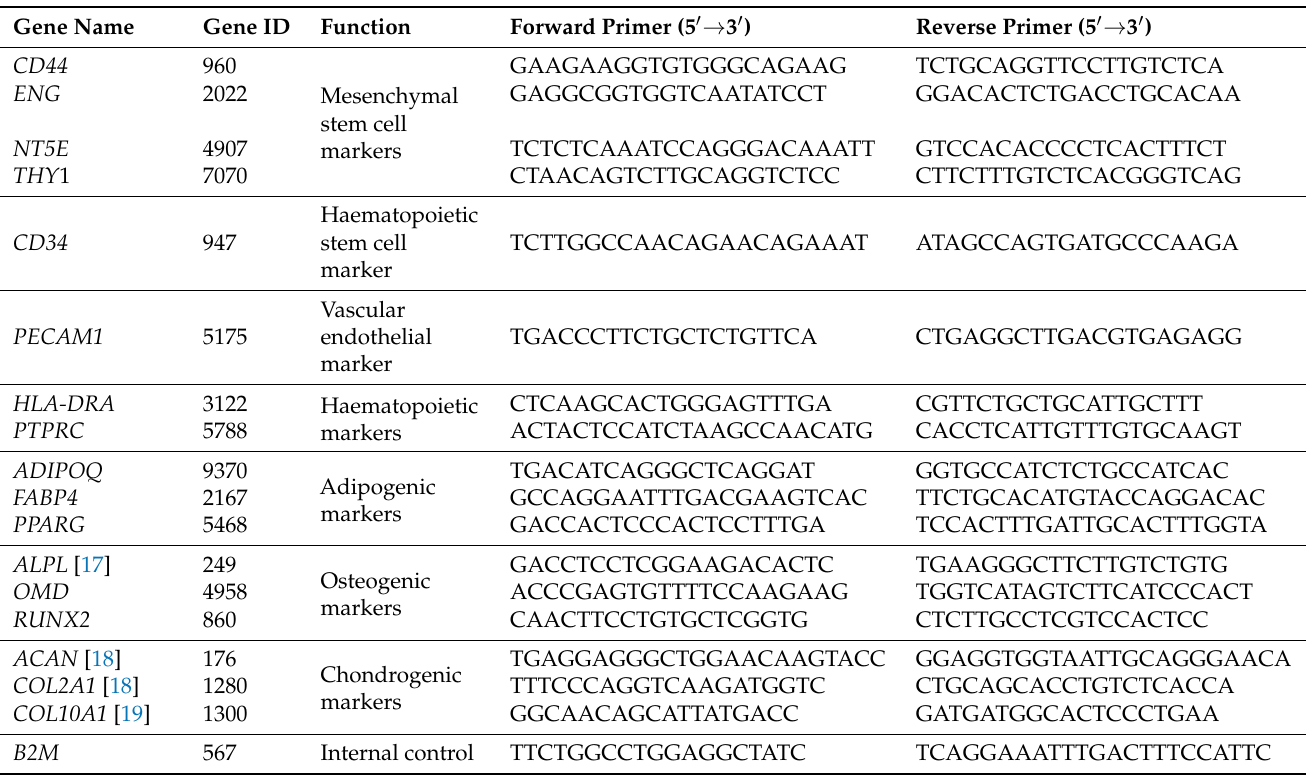
Table 1. qRT-PCR